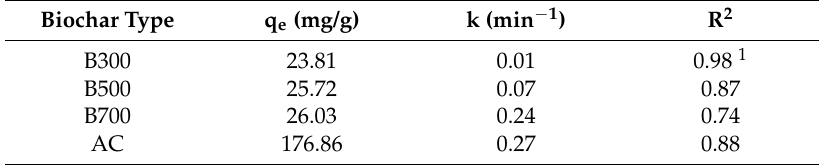
Table 2. Fitting results of adsorption kinetics of biochar for chloropicrin (CP).